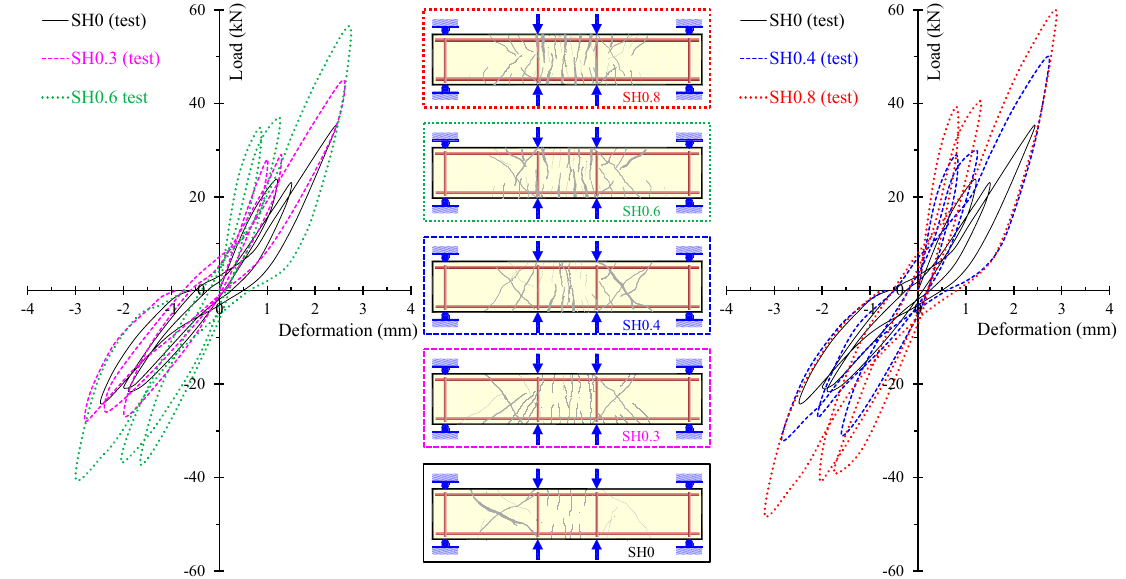
Figure 16. Influence of the steel fibers on the hysteretic and cracking behavior of the shear-critical beams without stirrups (group “SH” specimens).